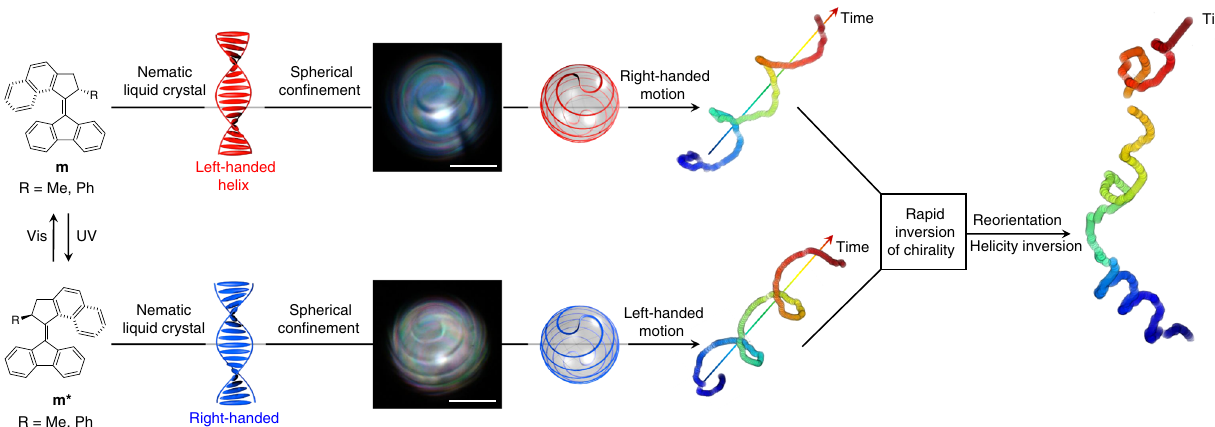
Fig. 1 Spiral droplets reorient their swim in response to light-induced helix inversion. The molecular chirality of motor m and its light-induced isomer m * is transmitted across increasing length scales, from a chiral center in the motor, to the helical shape of the motor and eventually to liquid crystal chirality (left- handed in red, right-handed in blue). In spherical con fi nement and with the liquid crystal molecules aligning perpendicularly to the interface, a double spiral disclination line forms at the surface of the droplet. This disclination line is visible under polarized optical microscopy (scale bar 50 μ m) and is also shown in the model of the droplet (red for left-handed and blue for right-handed). These chiral droplets are propelled along helical trajectories with a handedness that is opposite to that of the droplets. Upon illumination, the molecular motors invert the handedness of their helical shape, in a process that drives their rotation and leads to inversion of liquid crystal handedness. This light-induced inversion is associated with inversion of the helical trajectory and with a deterministic